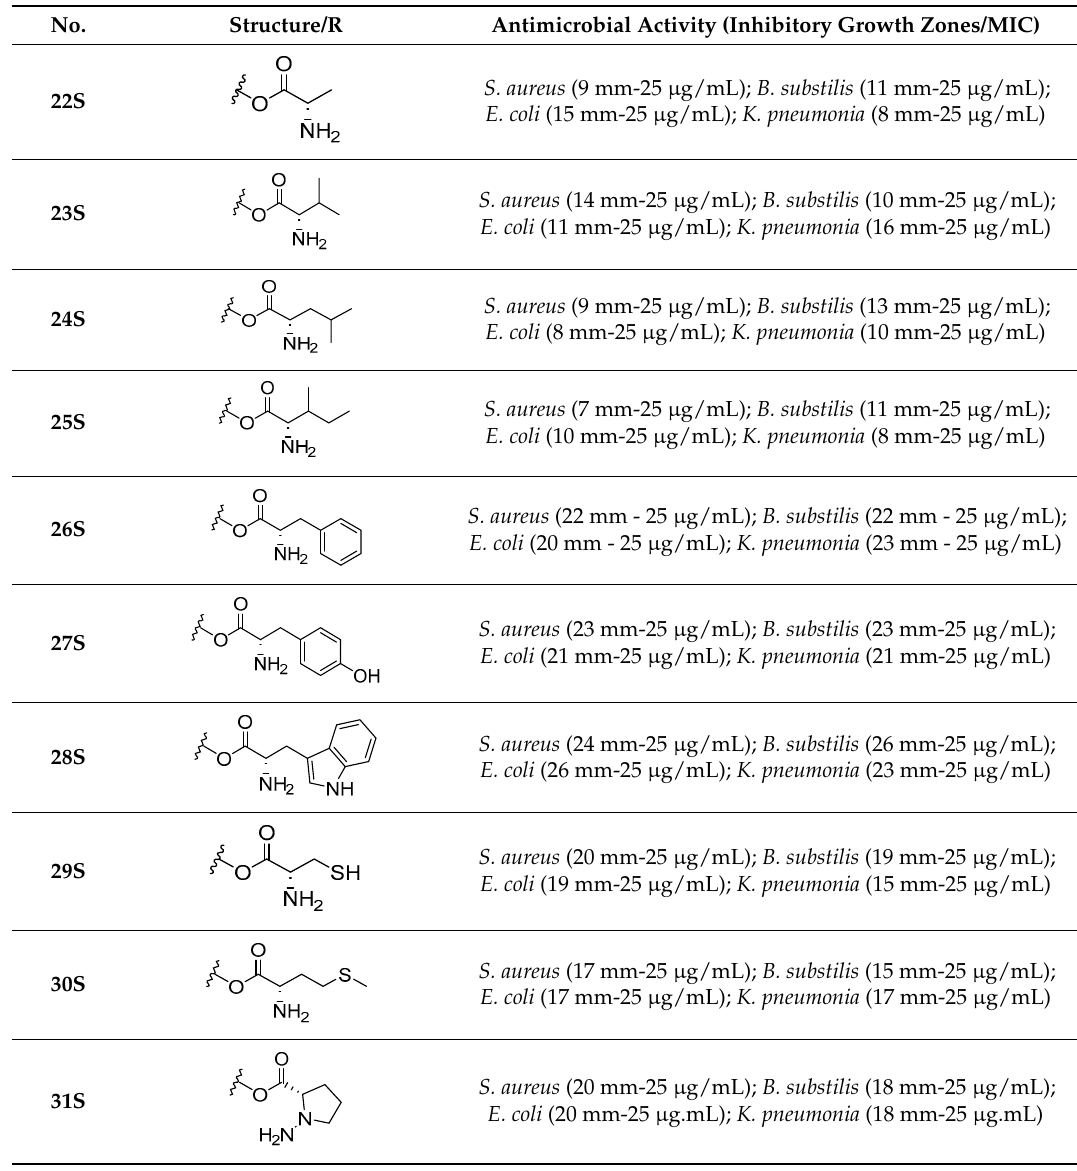
Table 10. Antimicrobial activity of α -mangostin analogues. No. Structure/R